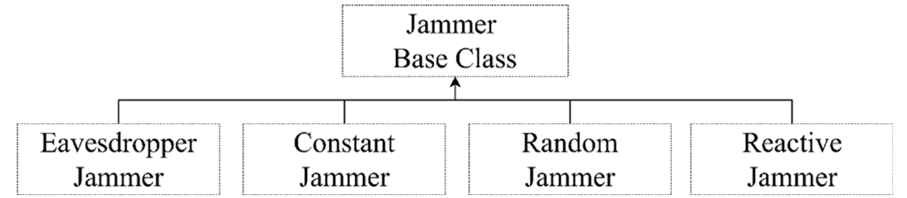
Figure 5. Detailed jammer types within the jammer component.